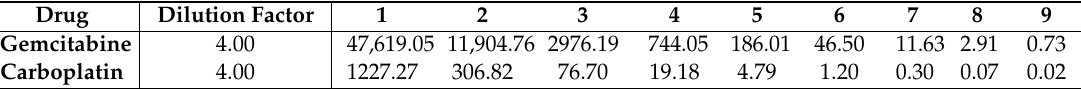
Table 1. Final concentrations of gemcitabine (ng / mL) and carboplatin ( µ g / ml) in the MTT assay.